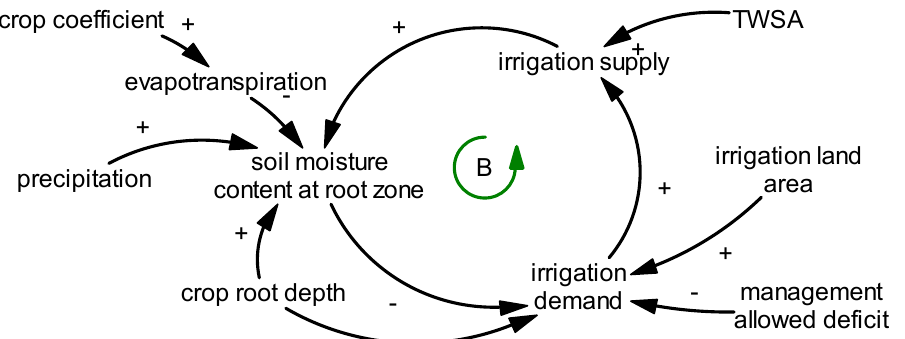
Figure 6. Causal loop diagram for irrigation scheduling. The ‘+’ sign with the arrow indicates two variables changing in the same direction, and the ‘ − ’ sign indicates the opposite direction. Balancing loops (negative feedback, labeled as ‘B’) balance the system over time, negating the impact of the disturbance.